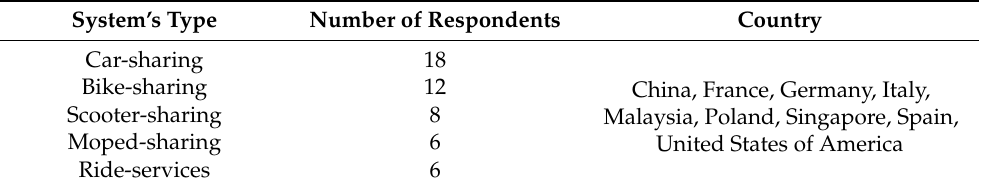
Table 2. Respondents’